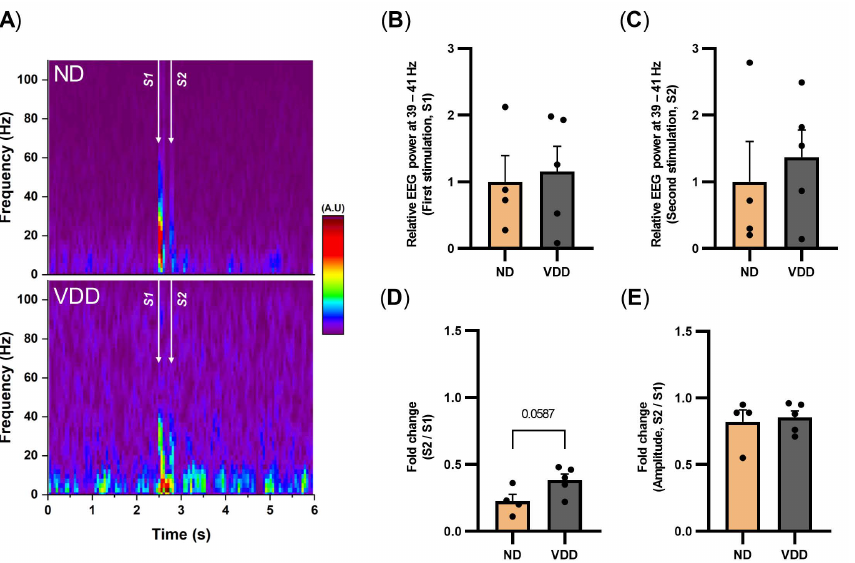
Figure 4. Prepulse inhibition reduced by vitamin D deficiency. ( A ) Representative averaged time- frequency spectrogram of frontal EEG from the normal diet and after the vitamin D-deficient diet at 20 weeks (ND, top; VDD, bottom). The arrows denote 5 kHz stimulation for 50 ms and the sound pressure was 90 dB. ( B – C ) Relative EEG power at 40 ± 1 Hz of stimulation 1 (S1, 2.5–2.55 s) and stimulation 2 (S2, 2.75–2.8 s). ( D ) Fold change during S2 period in comparison with S1 period. ( E ) Amplitude means the averaged traces’ peak amplitude during the stimulation period. Fold change during S2 period in comparison with S1 period. Data are expressed as mean ±